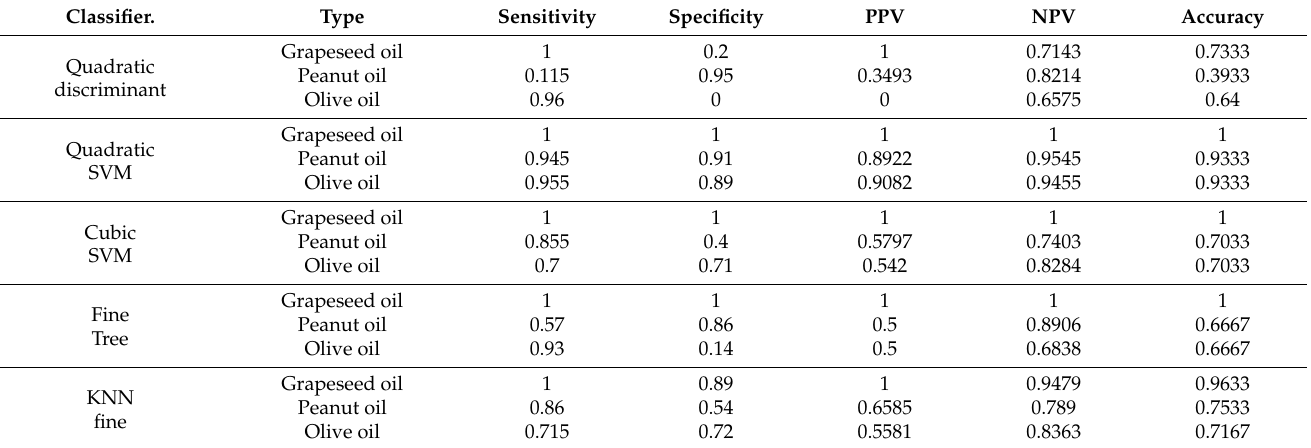
Table 2. Testing results using six different classifier models for oil